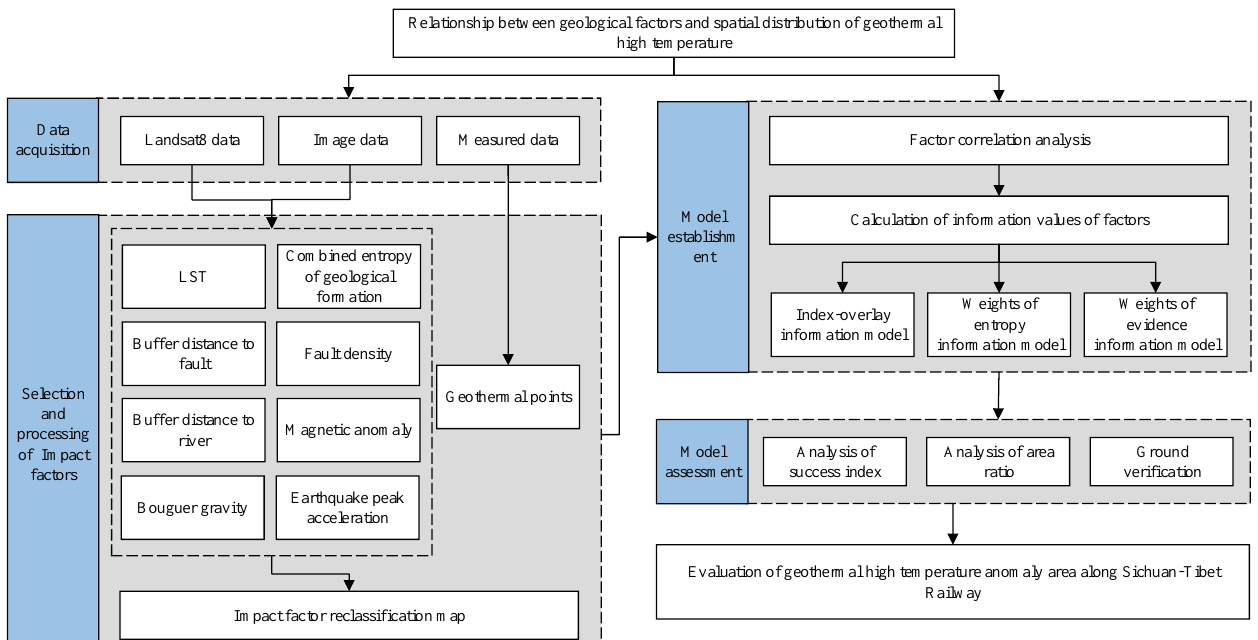
Figure 1. The technology and methodology flow chart.